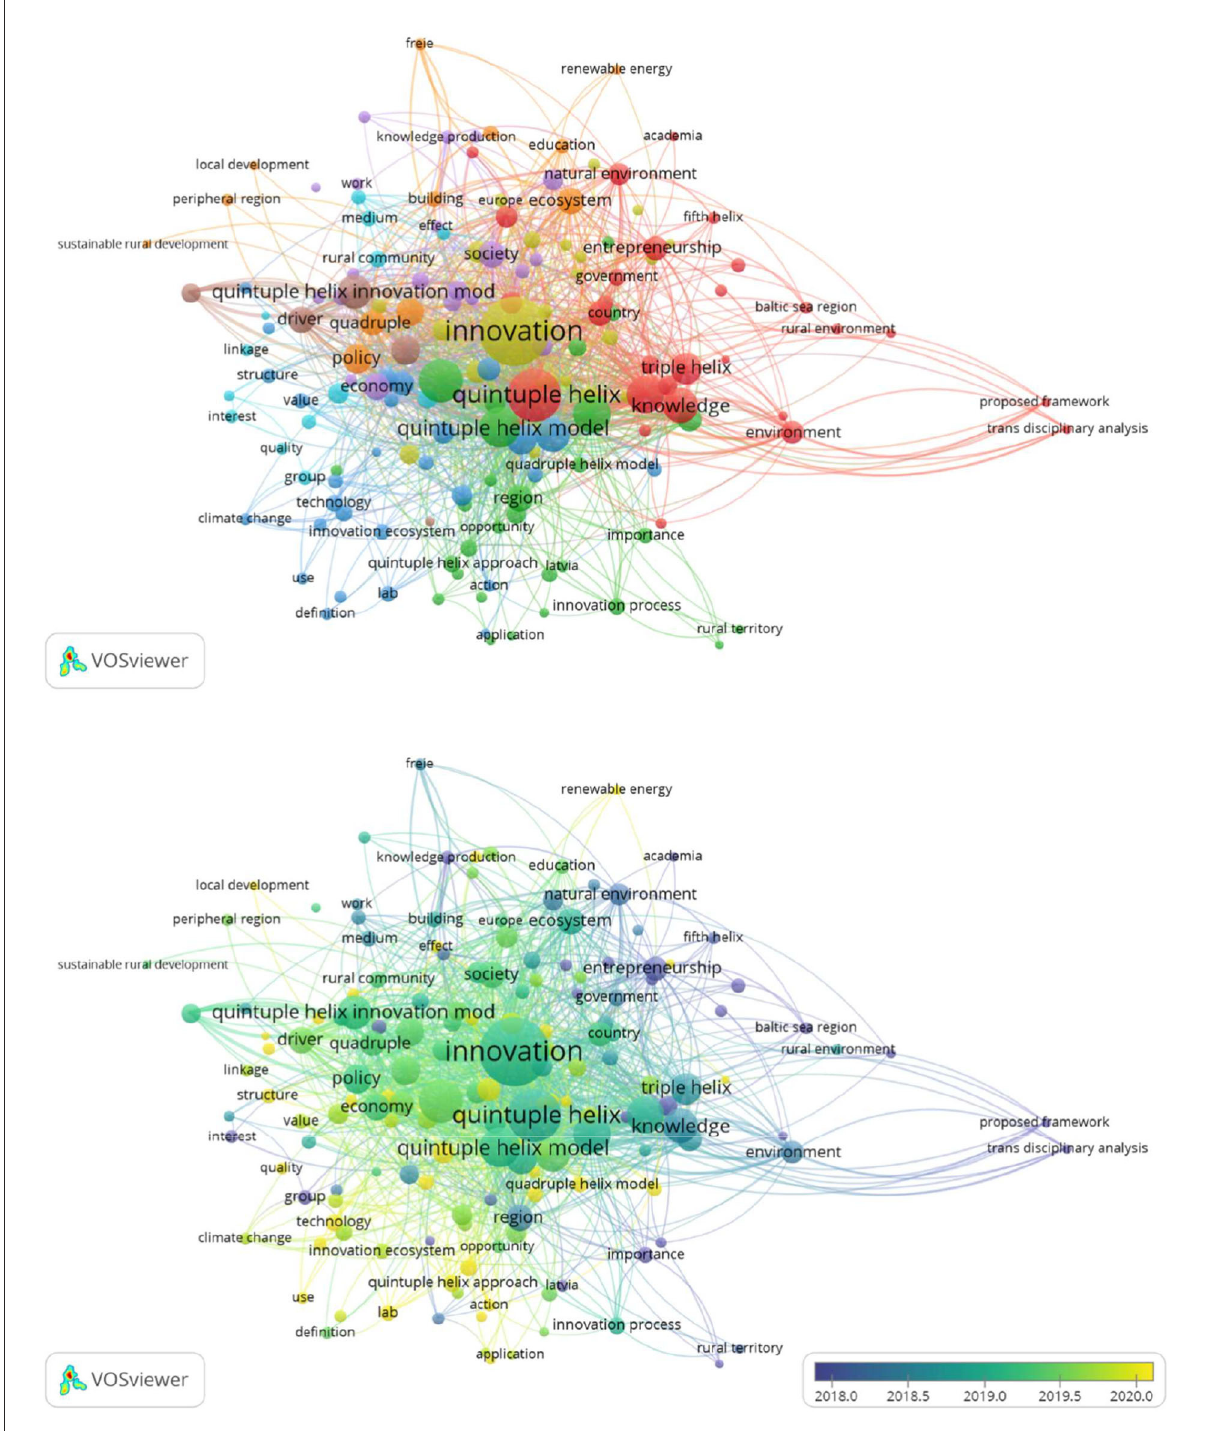
FIGURE1 Identification and analysis of research issues related to the Quintuple Helix Models and rural innovation programs. Source: Processed from VosViewer (2022).